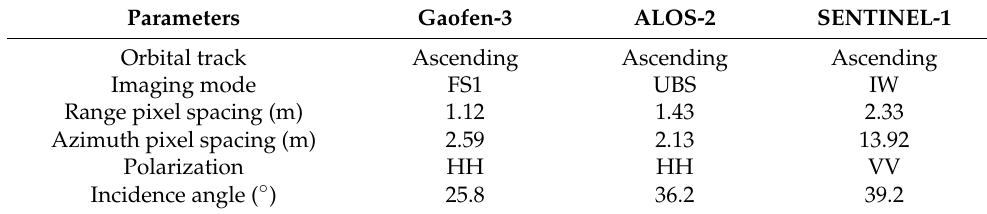
Table 2. Main parameters of each type of SAR images.